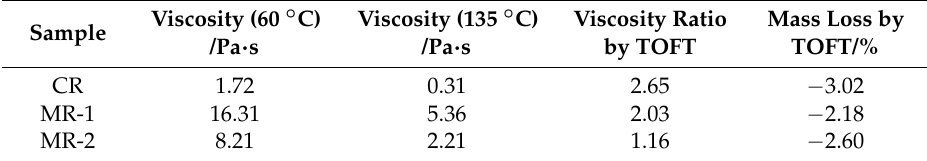
Table 2. Basic properties of the rejuvenators.